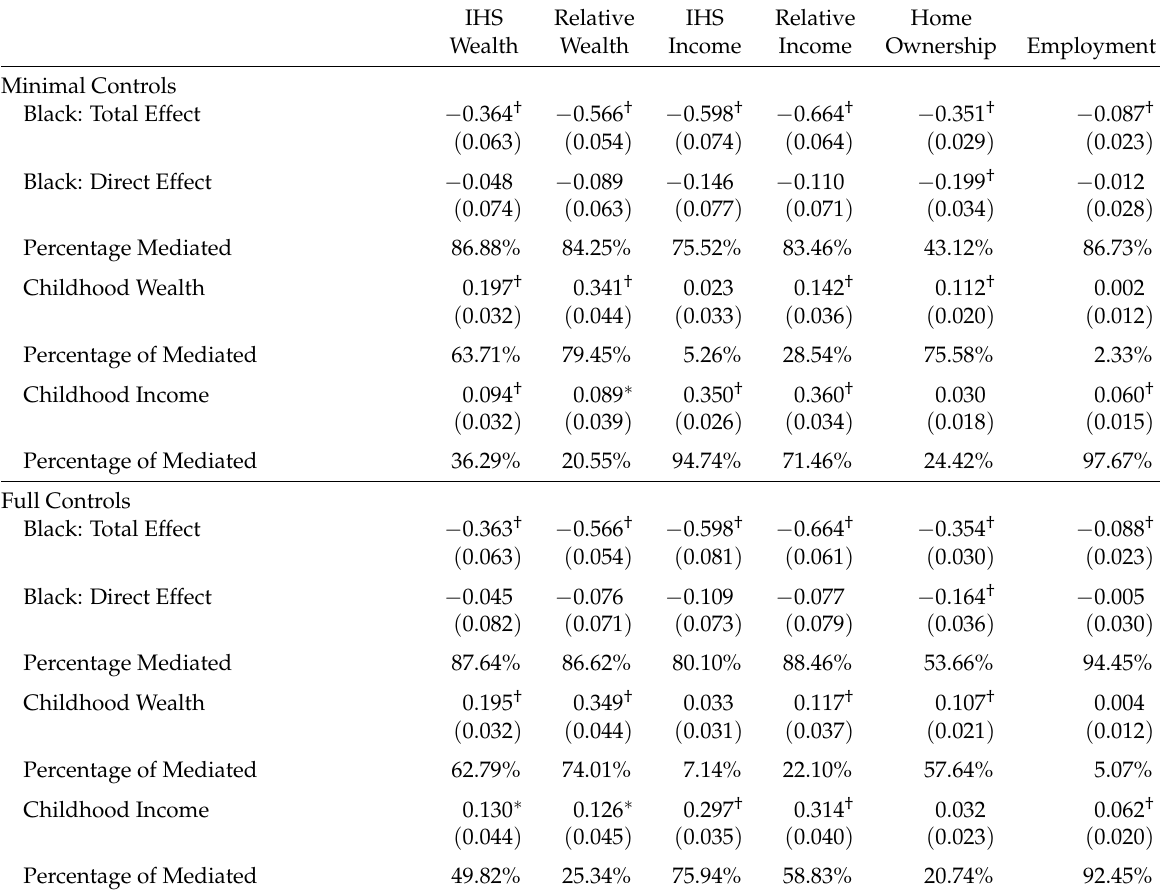
Table1: Economic outcomes: y -standardized coefficients or AMEs for being black and standardized coefficients or x -standardized AMEs for childhood wealth and